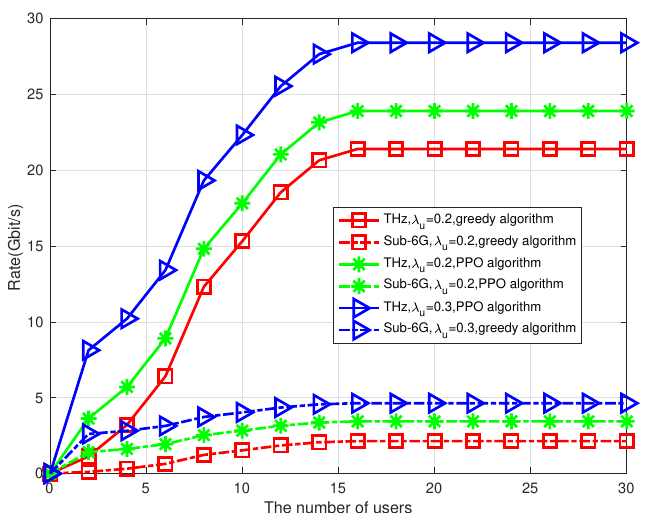
Figure 6. Relationship between rate and number of